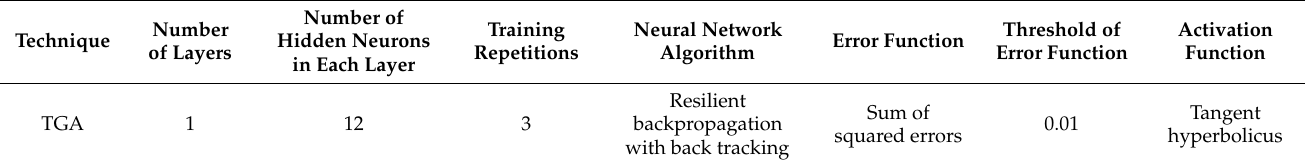
Table 1. Parameters used to perform the ANN